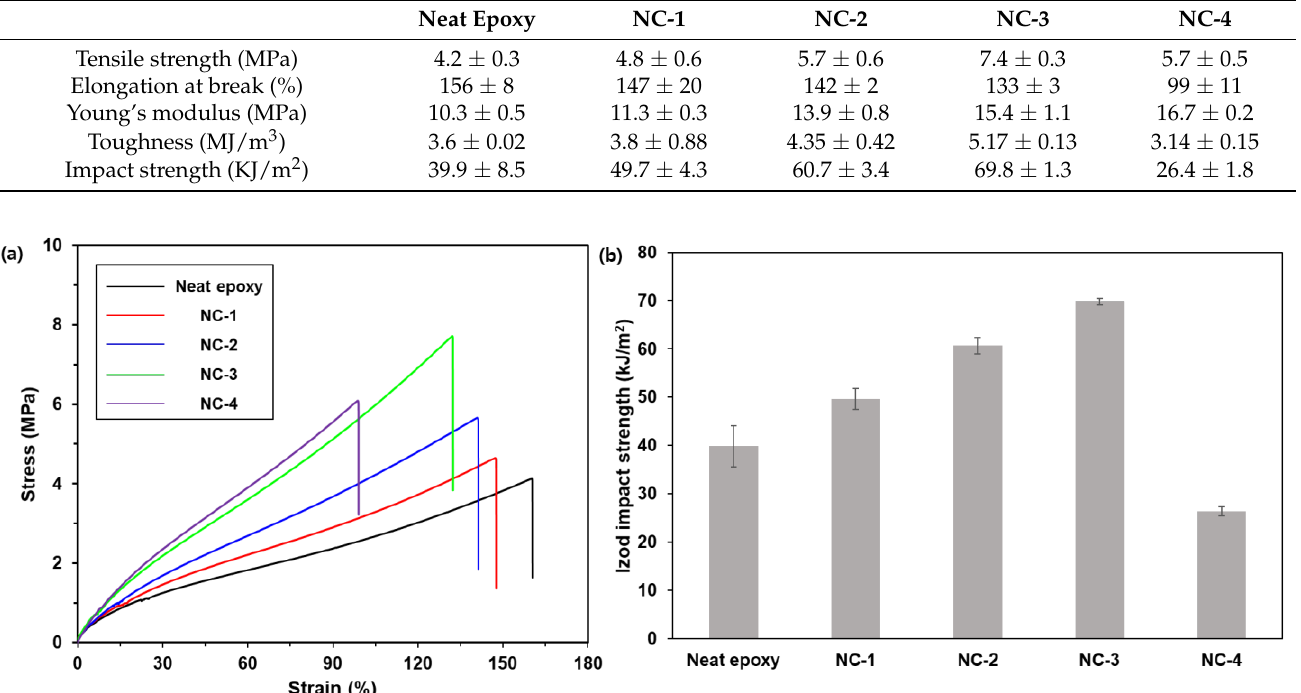
Figure 6. ( a ) Stress-strain curves of neat epoxy and nanocomposites and ( b ) Izod impact strength of nanocomposites.